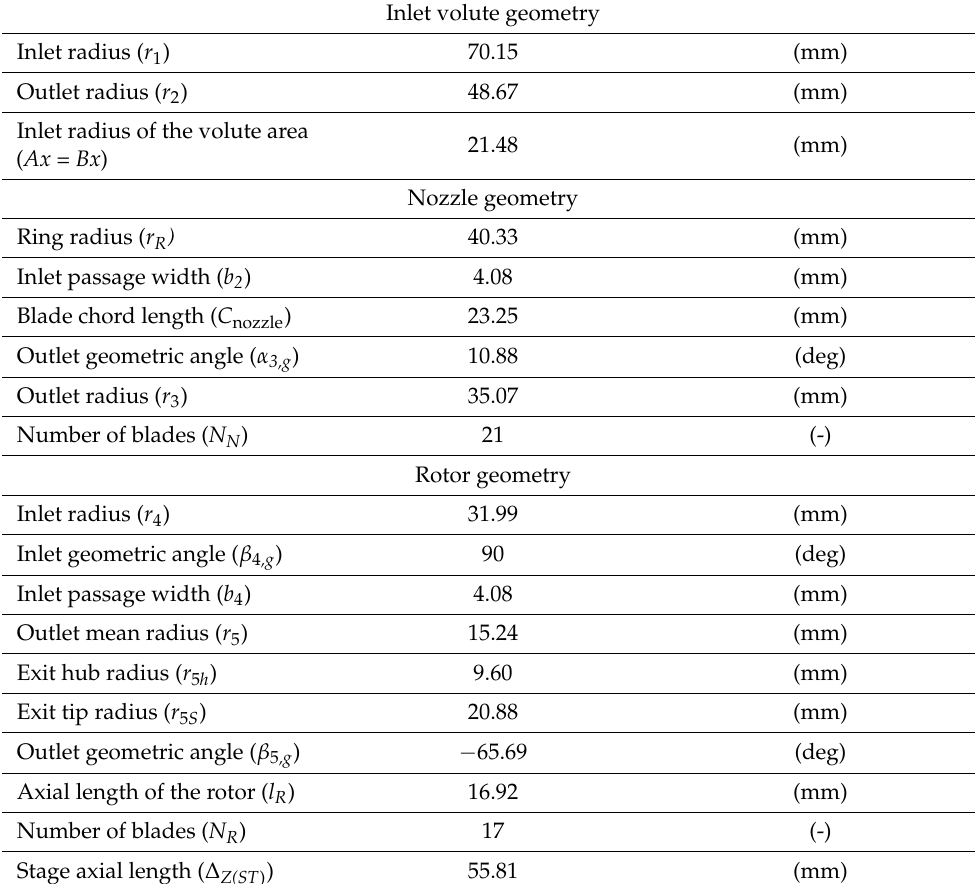
Table 2. Radial inflow turbine geometry determined through the design algorithm (explaining drawings are already reported in